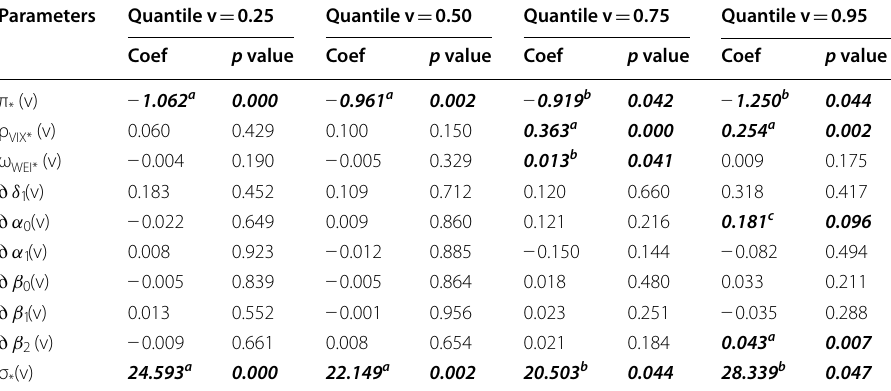
Table 3 QARDL results